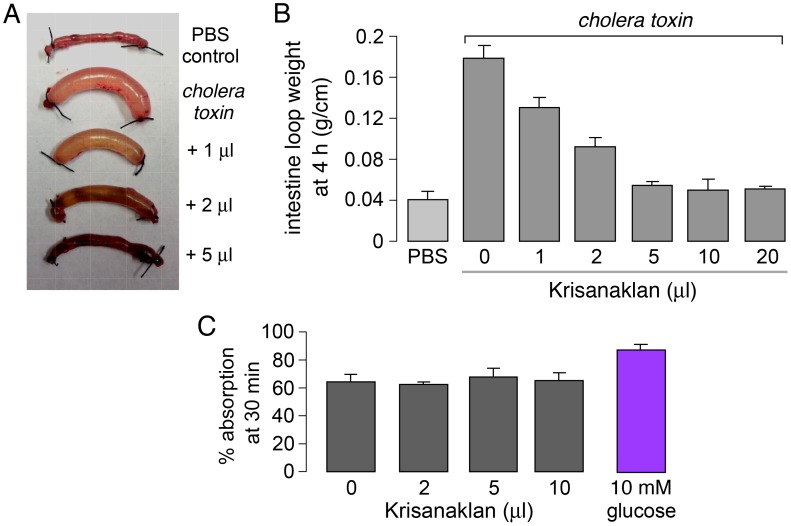
Krisanaklan inhibits fluid secretion in cholera toxin-treated intestinal loops in live mice.A. Closed jejunum loops removed from live mice at 4 µg cholera toxin, without or with Krisanaklan. Administration of 1 µL per loop represents a 1∶100 dilution of Krisanaklan. Saline (PBS) control (no cholera toxin) is shown for comparison (top). B. Intestinal loop weight/length at 4 h (mean ± S.E., 4 mice per group, 14–16 loops studied). C. Krisanaklan does not inhibit intestinal fluid absorption. Intestinal loop were injected with 200 µL buffer alone or with Krisanaklan. PBS containing 10 mM glucose was used as positive control. Loop weight/length was measured at 30 min (mean ± S.E., 4 loops).